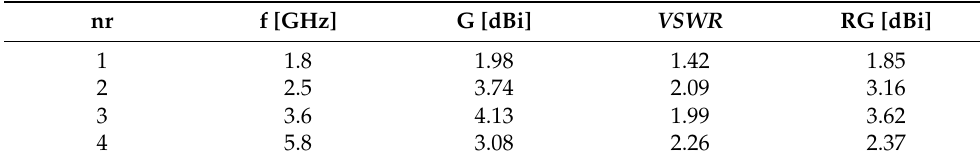
Table 5. Parameters of optimized two-circle antenna.